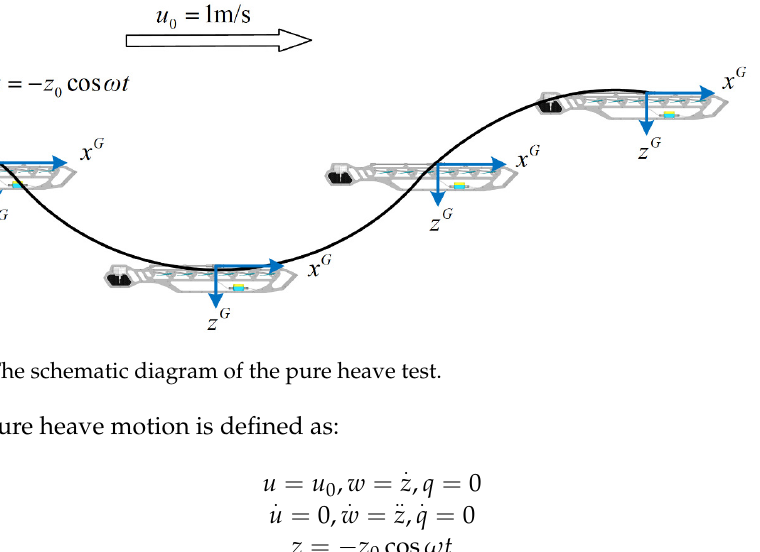
Figure 12. The schematic diagram of the pure heave test.